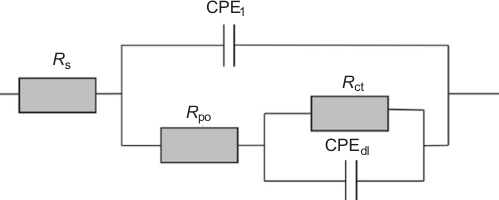
Fig. 11 Equivalent circuit of the corrosion fi lm. Describing the covered surface of the Fe-substrates immersed in m-SBF.